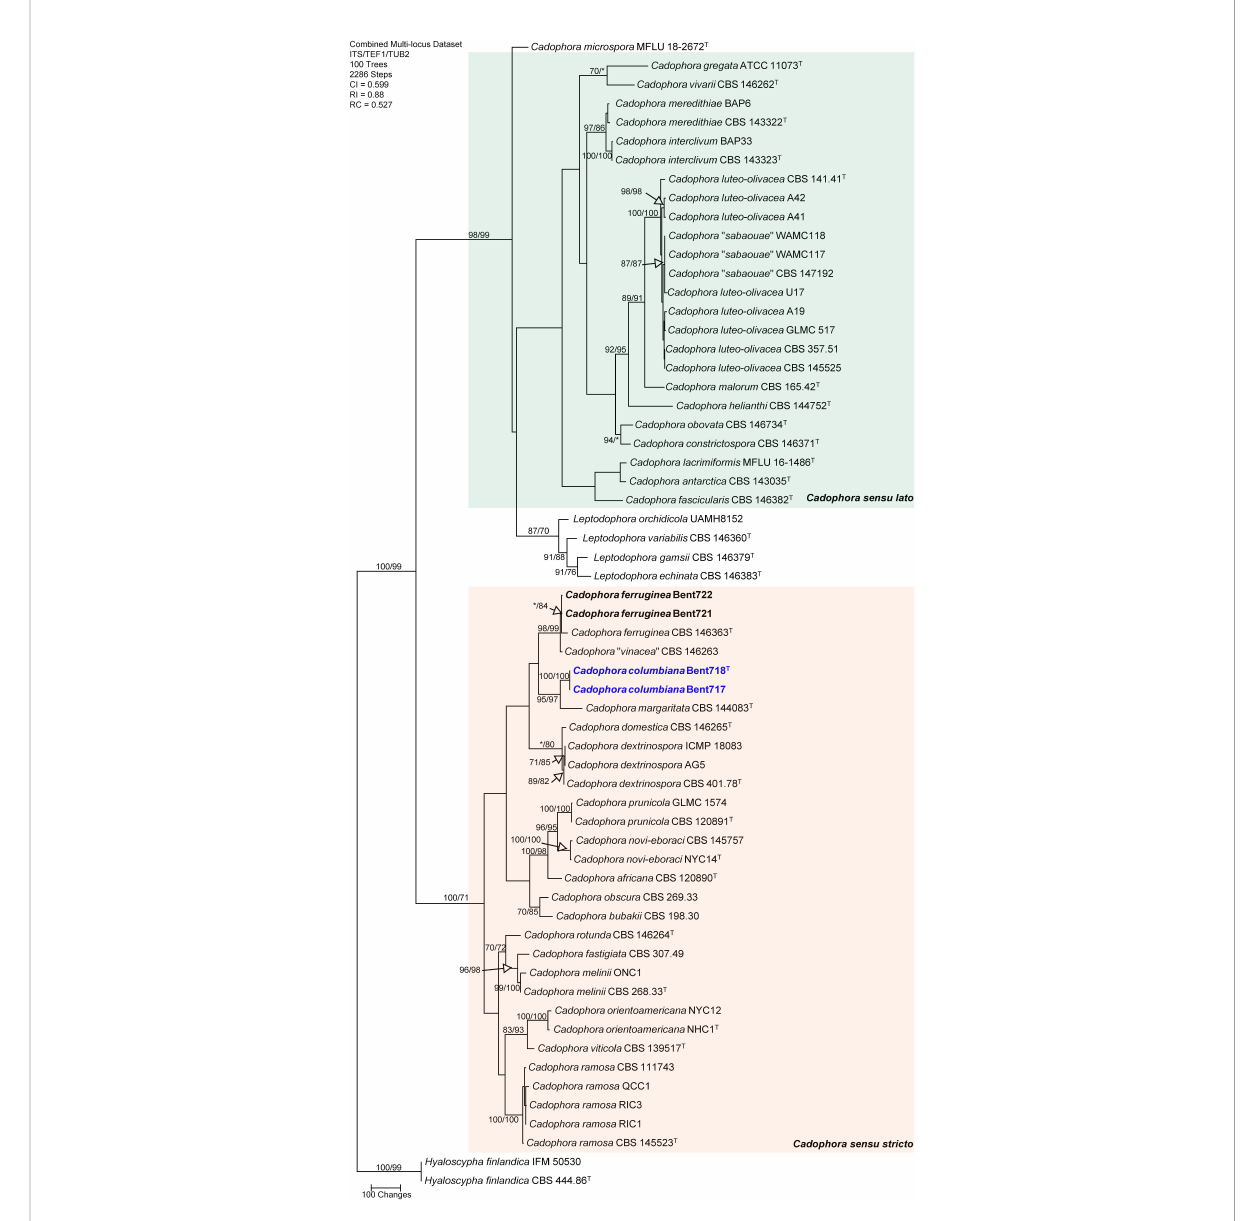
FIGURE 1 Phylogram generated from maximum parsimony analysis of the genus Cadophora based on a combined ITS, TEF1- a and TUB sequence dataset. Bootstrap support values for MP and ML equal to or greater than 70% are presented. The tree is rooted to Hyaloscypha fi nlandica (CBS 444.86 and IFM 50530). The new isolates are in bold and isolates of new species are in blue. Ex-type strains are noted with superscript